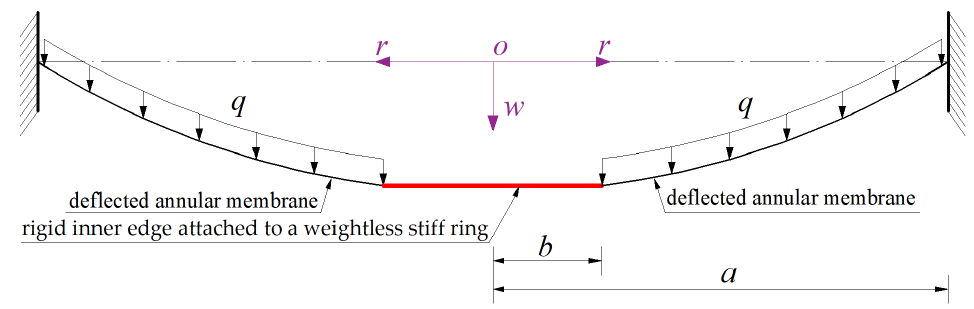
Figure 2. Sketch of the transversely and uniformly loaded hollow annular membrane.